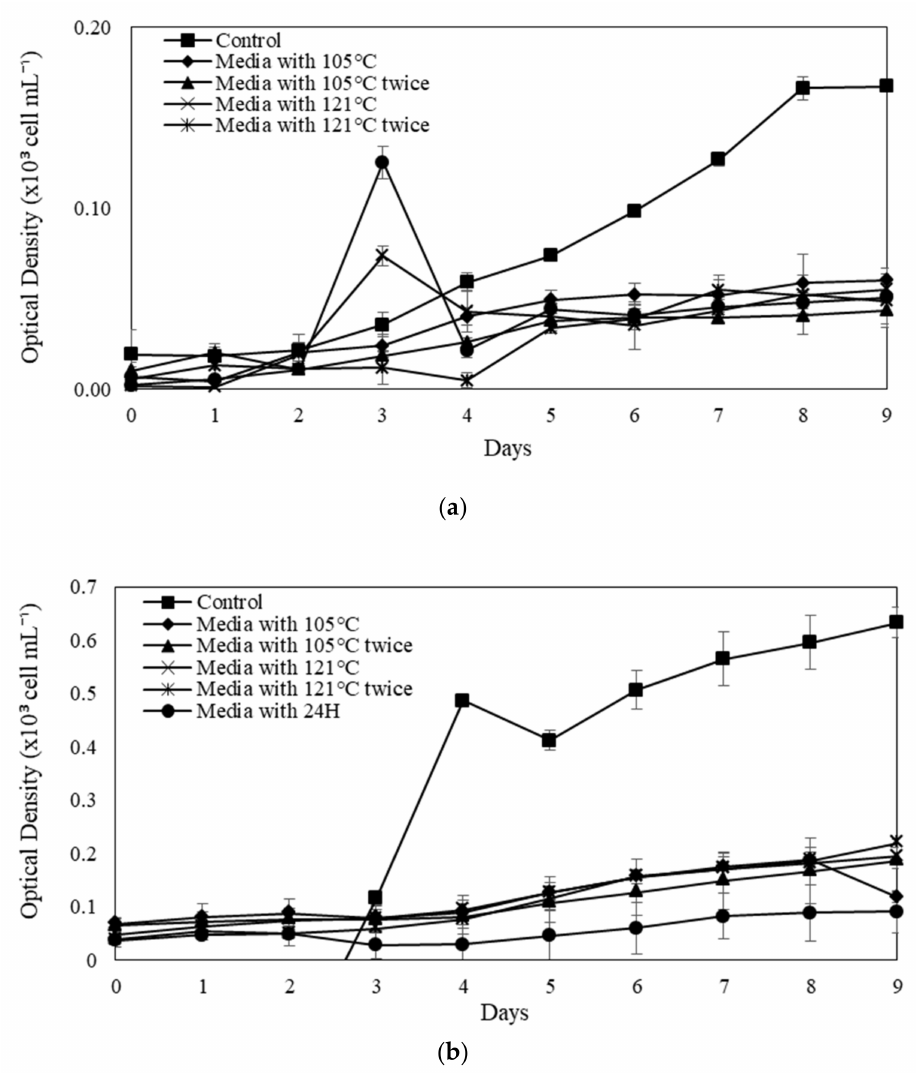
Figure 3. OD at 680 nm of C. radiosa in control (media without soil extract), media with 105 ◦ C, media with 105 ◦ C twice, media with 121 ◦ C, media with 121 ◦ C twice, and media with 24 h (media with 105 ◦ C—autoclave 105 ◦ C; media with 105 ◦ C twice—autoclave 105 ◦ C 2 × after natural extraction 24 h; media with 121 ◦ C—autoclave 121 ◦ C after natural extraction 24 h; media with 121 ◦ C × 2—autoclave 121 ◦ C twice after natural extraction 24 h; media with 24 h—natural extraction for 24 h). ( a ) RMFR SE and ( b ) AHFR SE. The error bars ( n = 3) indicating the standard